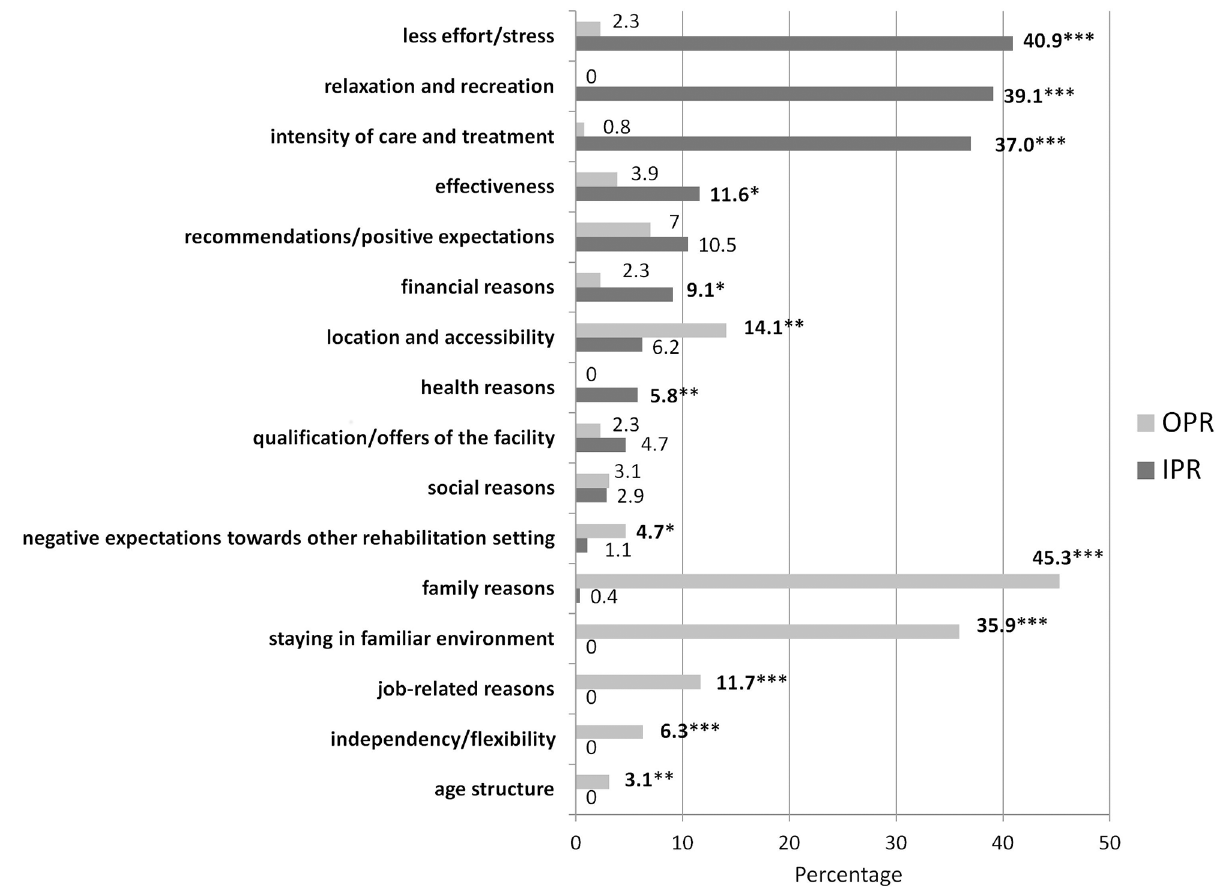
Fig 1. Patients´ motives for preferring a certain rehabilitation setting at baseline (T0). Calculations via Chi-Square-Tests; * p < .05, ** p < .01, *** p < .001; IPR, inpatientrehabilitation patients; OPR, outpatient rehabilitation patients; analysesonly comprise data of patients whose setting preferences at baselineand the actual setting attendance until Follow-upintervieware